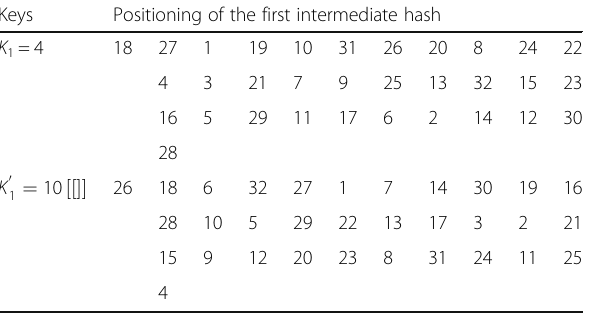
Table 10 Positioning of hash using different secret keys Keys Positioning of the first intermediate hash